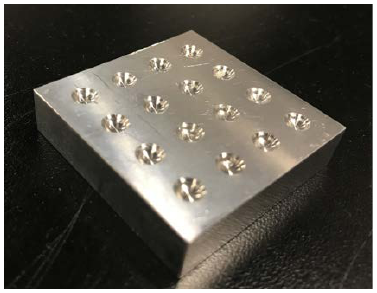
Figure 6. Mold for packaging MEMS pressure sensors.